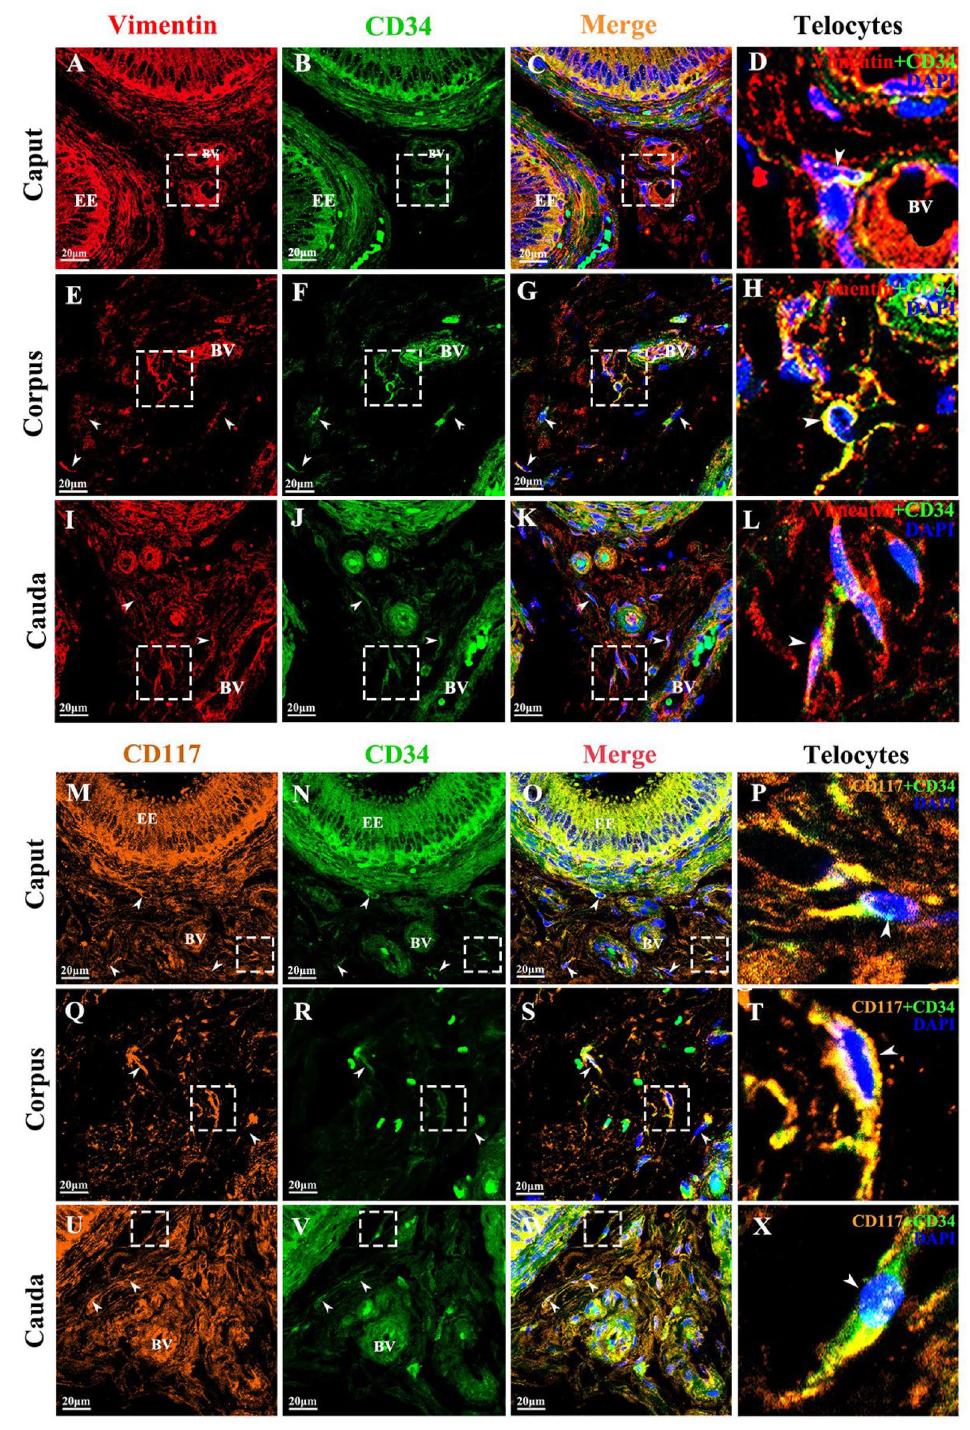
Figure 9. Double immunofluorescence results of yak epididymis staining for vimentin + CD34 and CD117 + CD34 (Scale bar = 20 μm). ( A – L ) Strong fluorescence expression of vimentin and CD34 in the epididymal epithelium and stroma. The co-expression of vimentin + CD34 was found around the capillary of the epididymal stroma. ( M – X ) Strong fluorescence expression of CD117 and CD34 in the epididymal epithelium and stroma. The co-expression of CD117 + CD34 was found around the capillary of the epididymal stroma. The co-expression position, shown by white arrows, denotes TCs. EE: Epididymal epithelium, BV: Blood